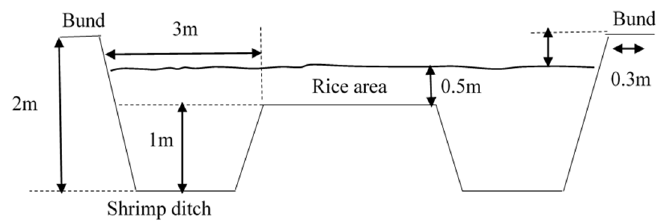
Figure 2. Cross section A–A of the system.